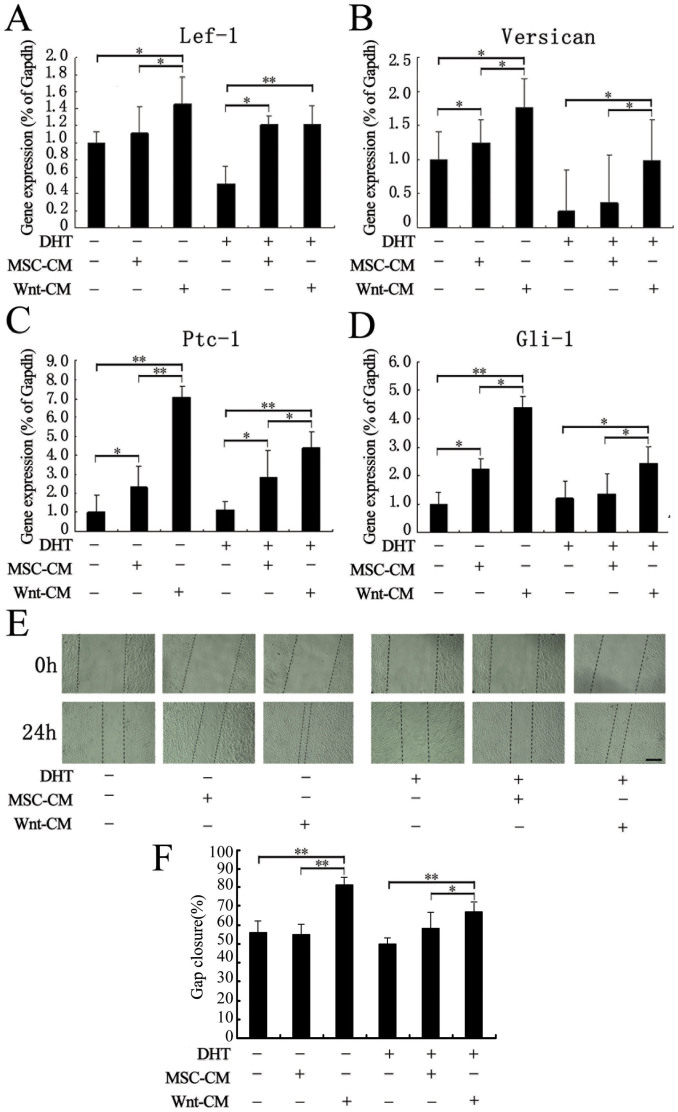
Wnt-CM enhances DP cell hair induction ability.(A–D) The qRT-PCR results revealed that Lef-1, Versican, Ptc-1, and Gli-1 were significantly downregulated in DHT-treated. THE expression of hair induction-related genes was enhanced by MSC-CM and Wnt-CM treatment. (E) The migration ability of DP cells was impaired by DHT according to the scratch test. (F) Quantitative analysis the scratch closure rate of DP cells cultured for 24 hours. The data represent the means ± SEM, n = 3. *P < 0.05 and **P < 0.01. Scale bar = 500 μm.